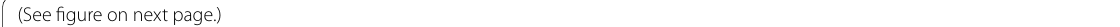
(See figure on next page.) Fig. 5 a Temporal variation of source radiation amplitude (circles) compared to the cumulative number of tremor events (solid curve). b (cid:31) CFF at the plate boundary in our study area due to Earth’s tides. c Hourly number of tremor events (bars) and (cid:31) CFF (dashed curve) during 27–30 December 2020. Red dashed lines denote the origin time of teleseismic earthquakes, for which the approximate location, depth, and magnitude estimated by the GCMT project (Ekström et al. 2012) are